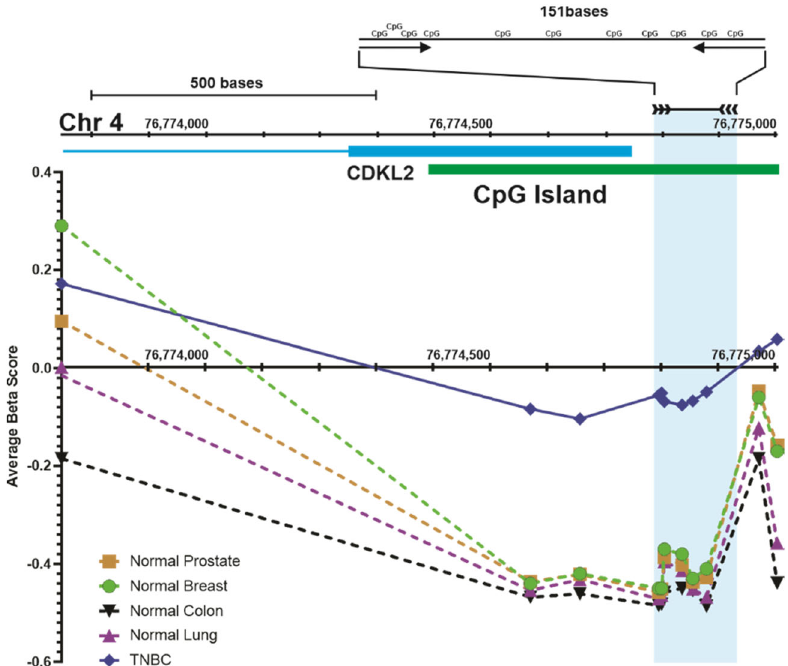
Fig. 2 Methylation in the promoter region of the gene CDKL2 in tumour and normal samples. Identi fi cation of differentially methylated target regions. Illumina 450 K methylarray probe beta values from various TCGA databases in the CDKL2 promoter were averaged (average beta value) for normal prostate (normal prostate), colon (normal colon), lung (normal lung), and breast (normal breast) tissues, and for triple- negative breast cancer (TNBC) from selected TCGA datasets. The methylation values for the each of these samples were plotted relative to genomic position on the x -axis (hg18 nucleotide position on Chromosome 4) to determine the extent of differential methylation in surrounding areas. The fi rst exon of the CDKL2 gene is shown (blue box) along with the identi fi ed CpG island (CpG Island in green). The location of the CDKL2 probe is shown (light-blue box) and the expanded region shows the location of CpG residues in relation to the PCR primers (arrows) and